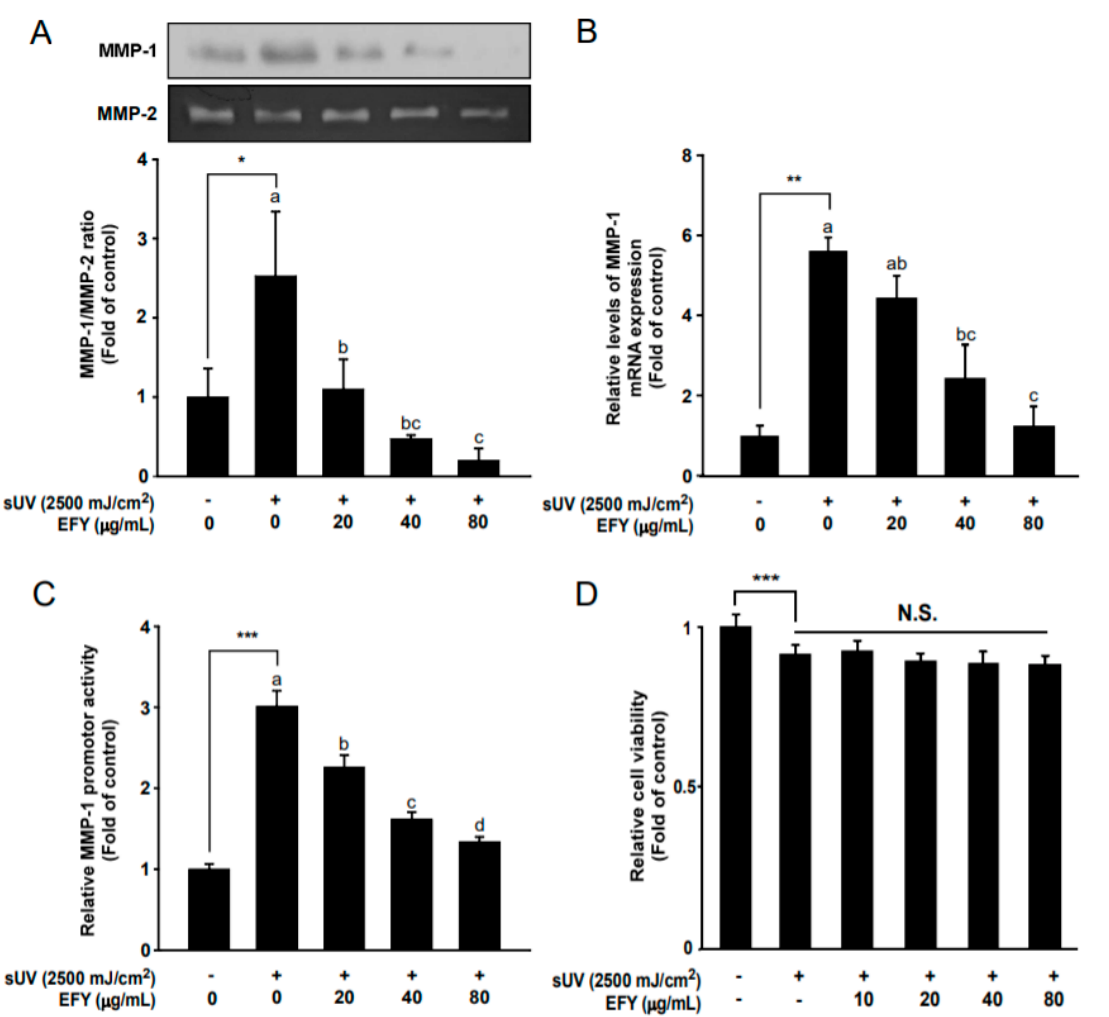
Figure 2. EFY inhibits sUV-induced MMP-1 protein secretion and reduces mRNA transcription via the suppression of MMP-1 promoter activity. ( A ) Inhibitory effects of EFY on sUV-induced MMP-1 protein secretion and Quantification of the effects of EFY on sUV-induced MMP-1 protein secretion. ( B ) Reduction in sUV-induced MMP-1 mRNA expression due to EFY. ( C ). MMP-1 promoter activity in HaCaT cells. ( D ). Cell viability was measured using a MTT assay. Data ( n = 3) are mean values ± SD. *** significant difference ( p < 0.001), ** ( p < 0.01) and * ( p < 0.05) between the control and sUV-exposed control. N.S., not significant. Mean values with different letters indicate statistically significant differences among sUV-exposed groups ( p < 0.05). Representative western blots from three independent experiments are shown ( n = 3).